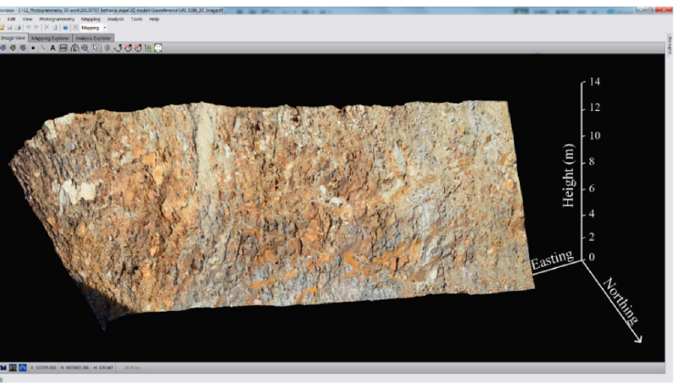
Figure 6. Three-dimensional slope surface model obtained from Sirovision [21].